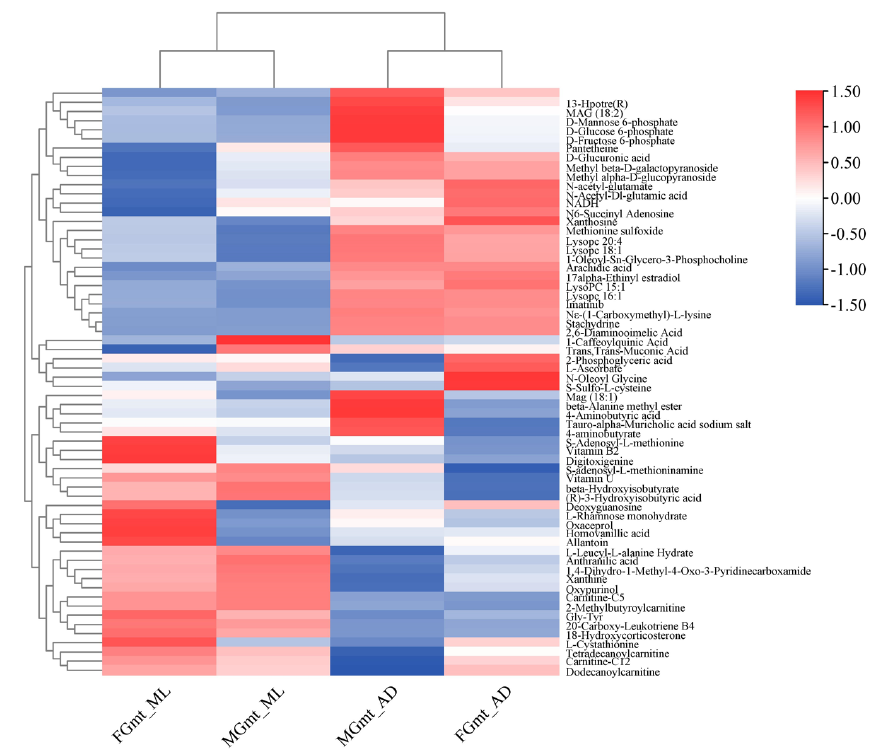
Figure 4. Total differential metabolite cluster heat map. The vertical axis shows the clustering of samples, the horizontal shows the clustering of metabolites; the shorter the cluster branch, the higher the similarity. The depth of the red color represents the relative level of the up-regulated metabolites, and blue represents down-regulated metabolic pathways.